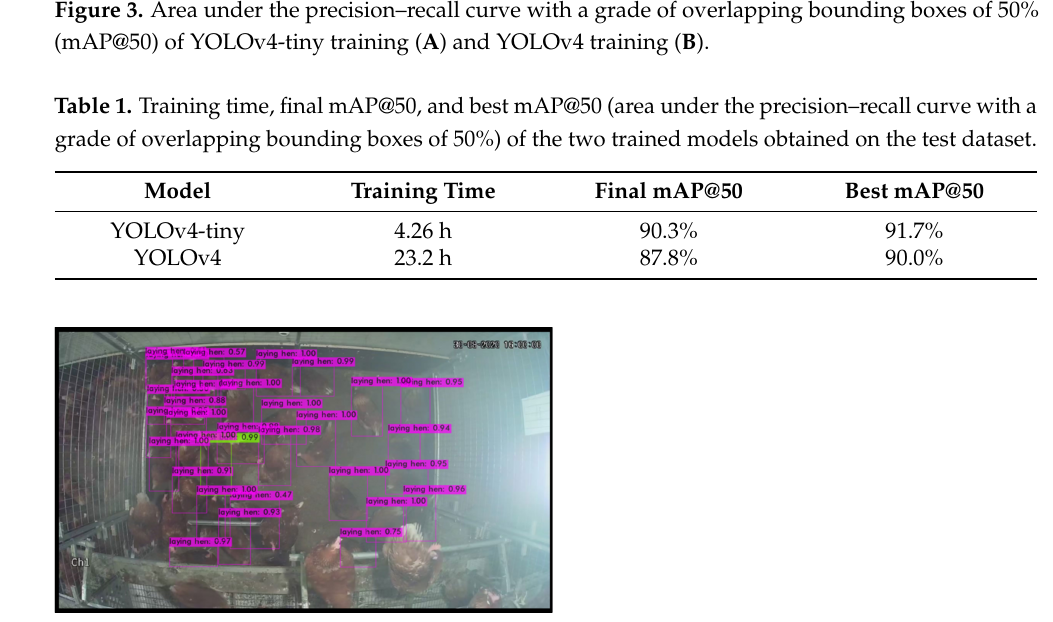
(mAP@50) of YOLOv4-tiny training ( A ) and YOLOv4 training ( B ).